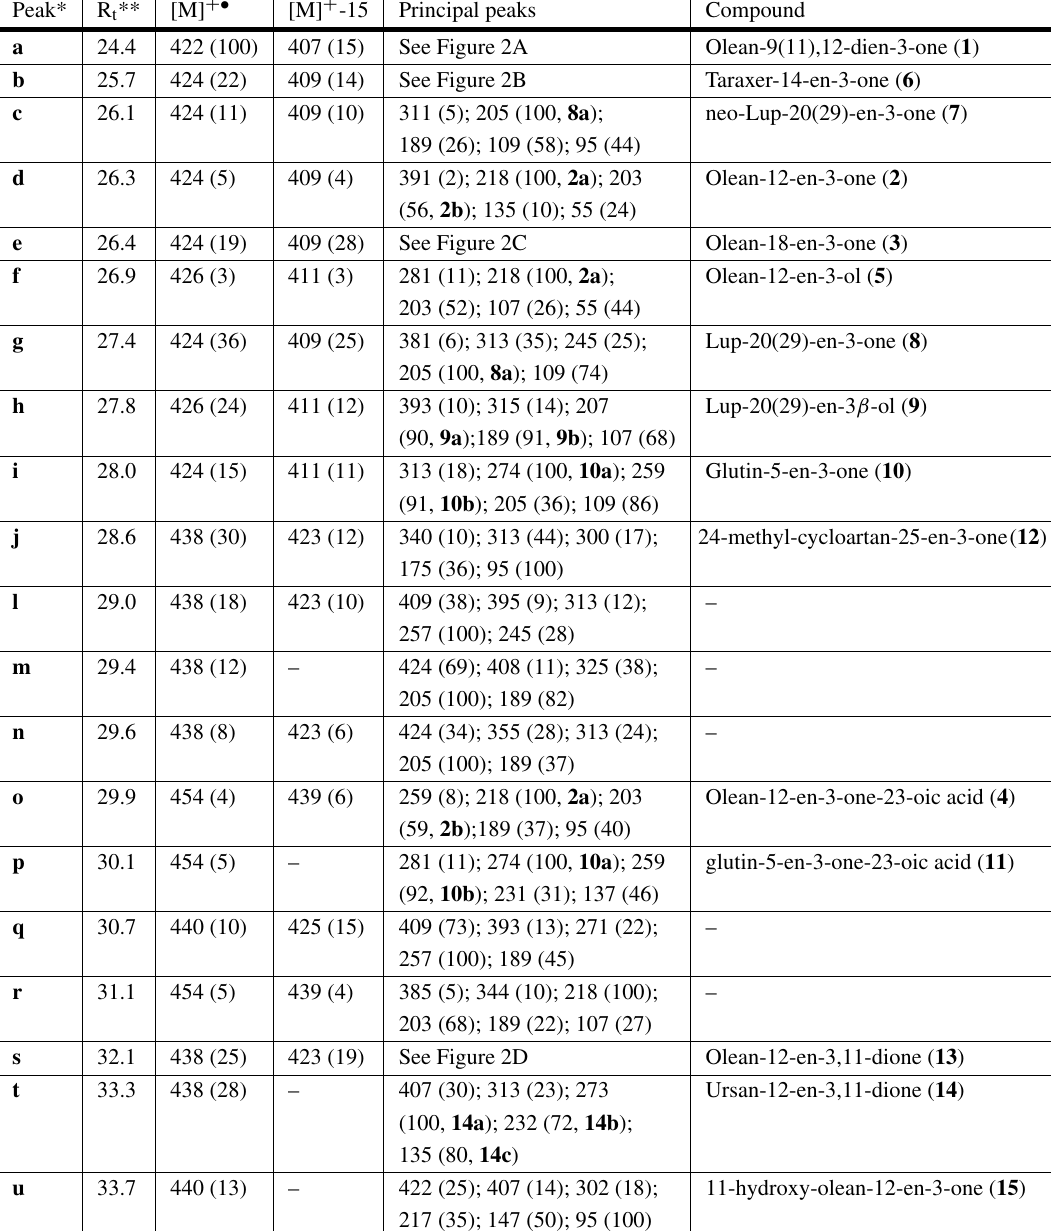
Principal peaks observed in the mass spectra ( m/z and relative intensity in parenthesis) of the triterpenes isolated from V. graminifolia